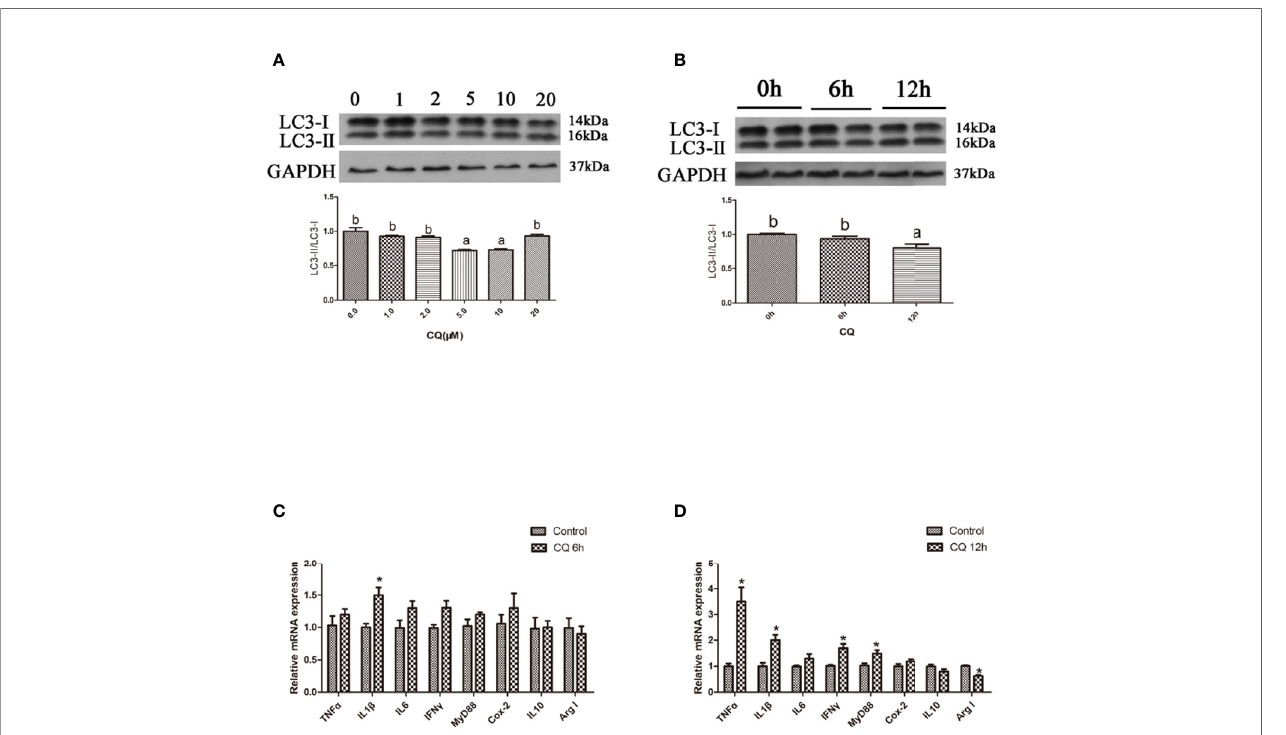
FIGURE 4 | Inhibition of autophagy could up-regulate the expression of in fl ammatory genes in vitro . (A) The ratio of LC3-II/LC3-I was analyzed by western blots in primary hepatocyte after treatment of different levels of CQ (n=3). (B) The ratio of LC3-II/LC3-I was analyzed by western blots in primary hepatocyte after treatment of different time of CQ (n=3). (C) The mRNA expressions of TNF a , IL1 b , IL6, IFN g , MyD88, Cox-2, IL10 and Arg I were analyzed by qRT-PCR in primary hepatocyte after treatment of 5 µM CQ for 6h (n=6). (D) The mRNA expressions of TNF a , IL1 b , IL6, IFN g , MyD88, Cox-2, IL10 and Arg I were analyzed by qRT-PCR in primary hepatocyte after treatment of 5 µM CQ for 12h (n=6). Results were represented as means with SEM and signi fi cance was evaluated by one-way ANOVA followed by Tukey ’ s multiple range tests or independent t tests (* P < 0.05). a,b,c Means share a same superscript letter are not signi fi cantly different ( P ≥